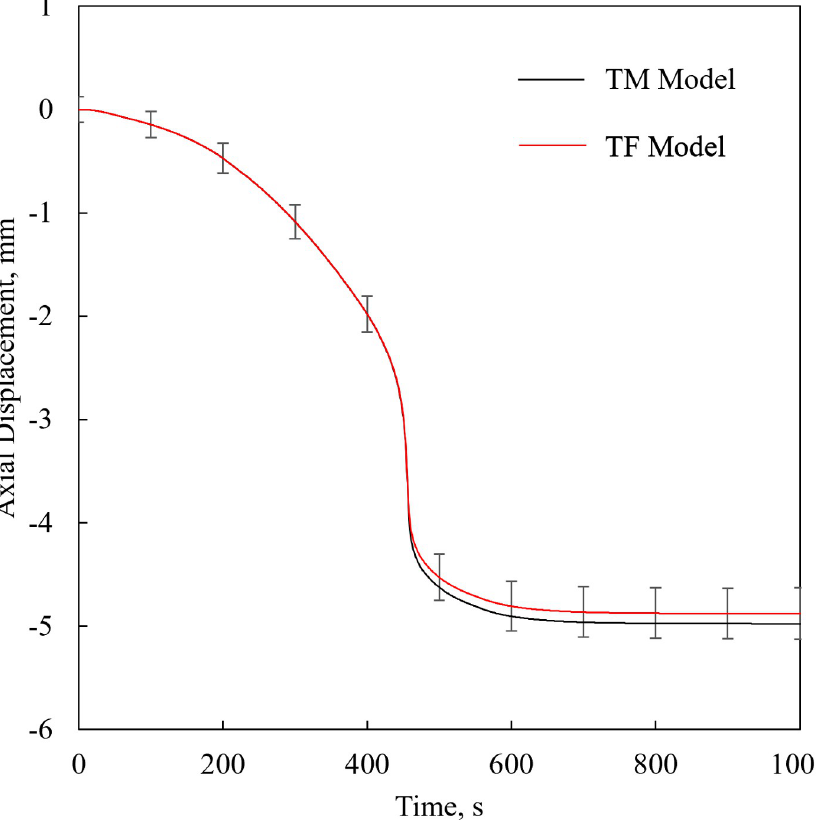
Fig 7. 2D TF vs TM model. Comparison of displacement histories along the centerline of the container between the 2D TM and TF 2D models for a cooling rate of 20F0B0C/min. The error bars refer to the uncertainty in experimental measurements for reference, although the displayed results are of